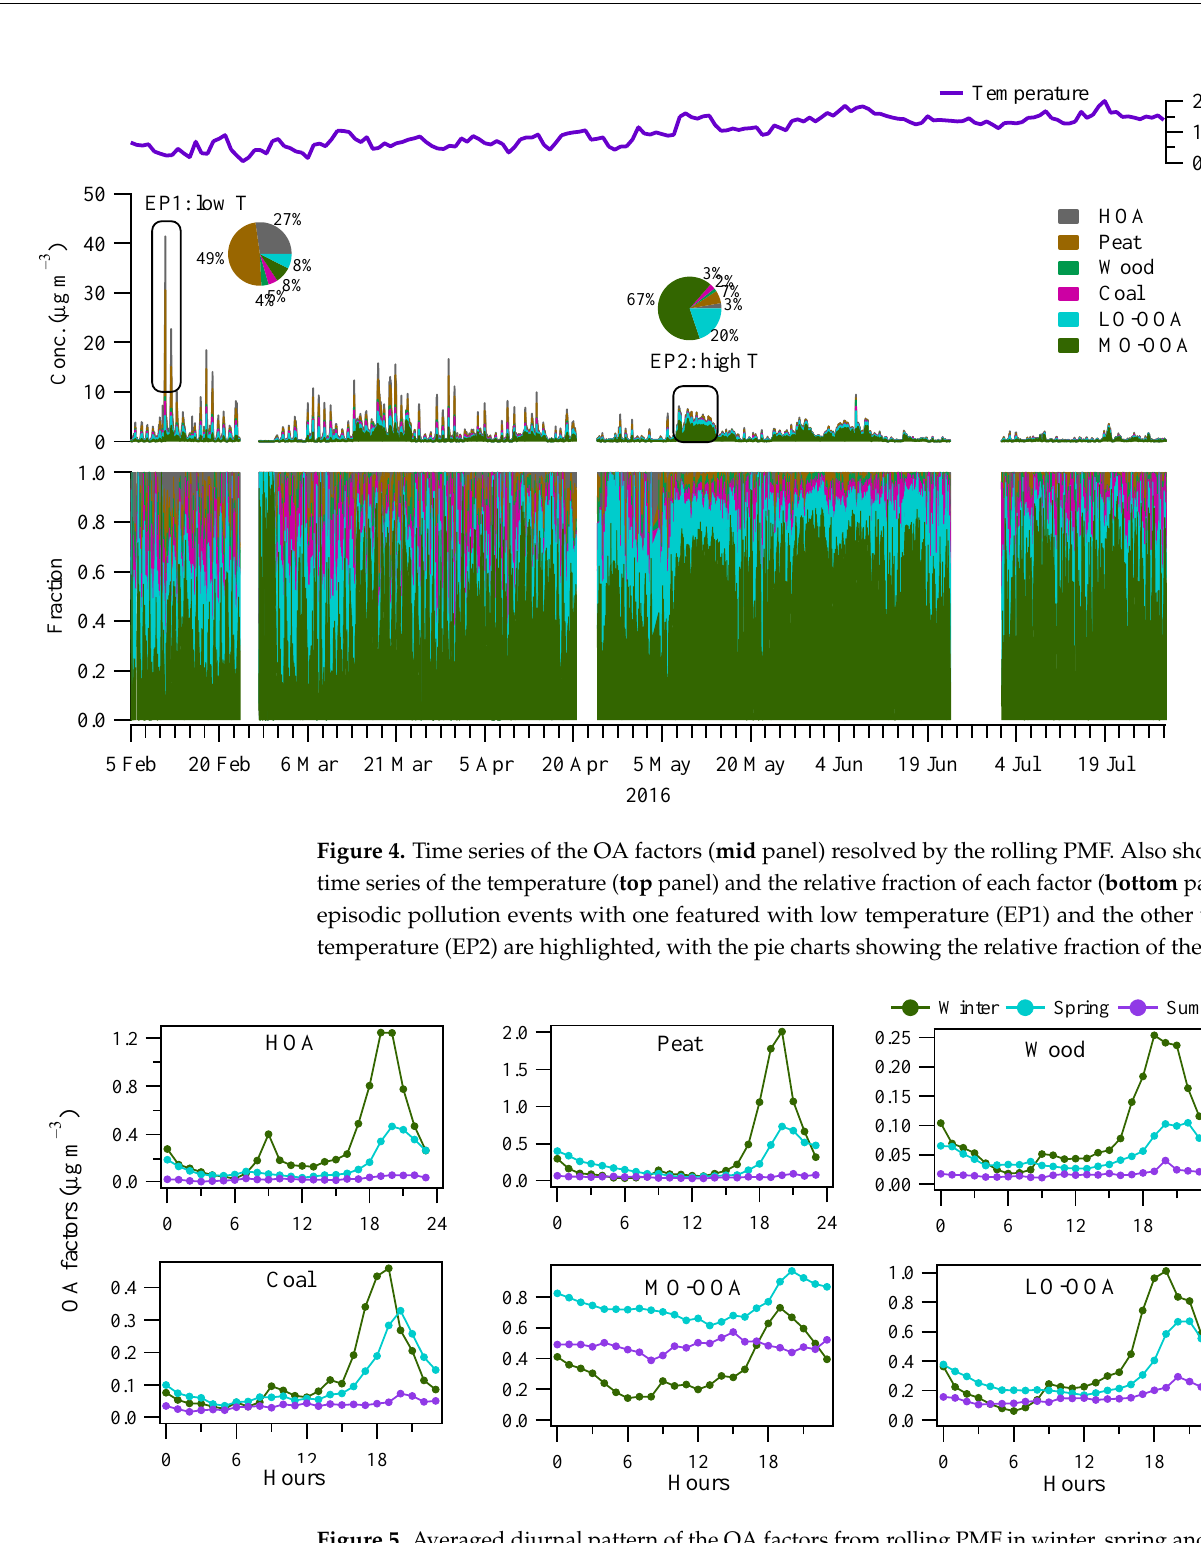
Figure 5. Averaged diurnal pattern of the OA factors from rolling PMF in winter, spring and sum- mer.